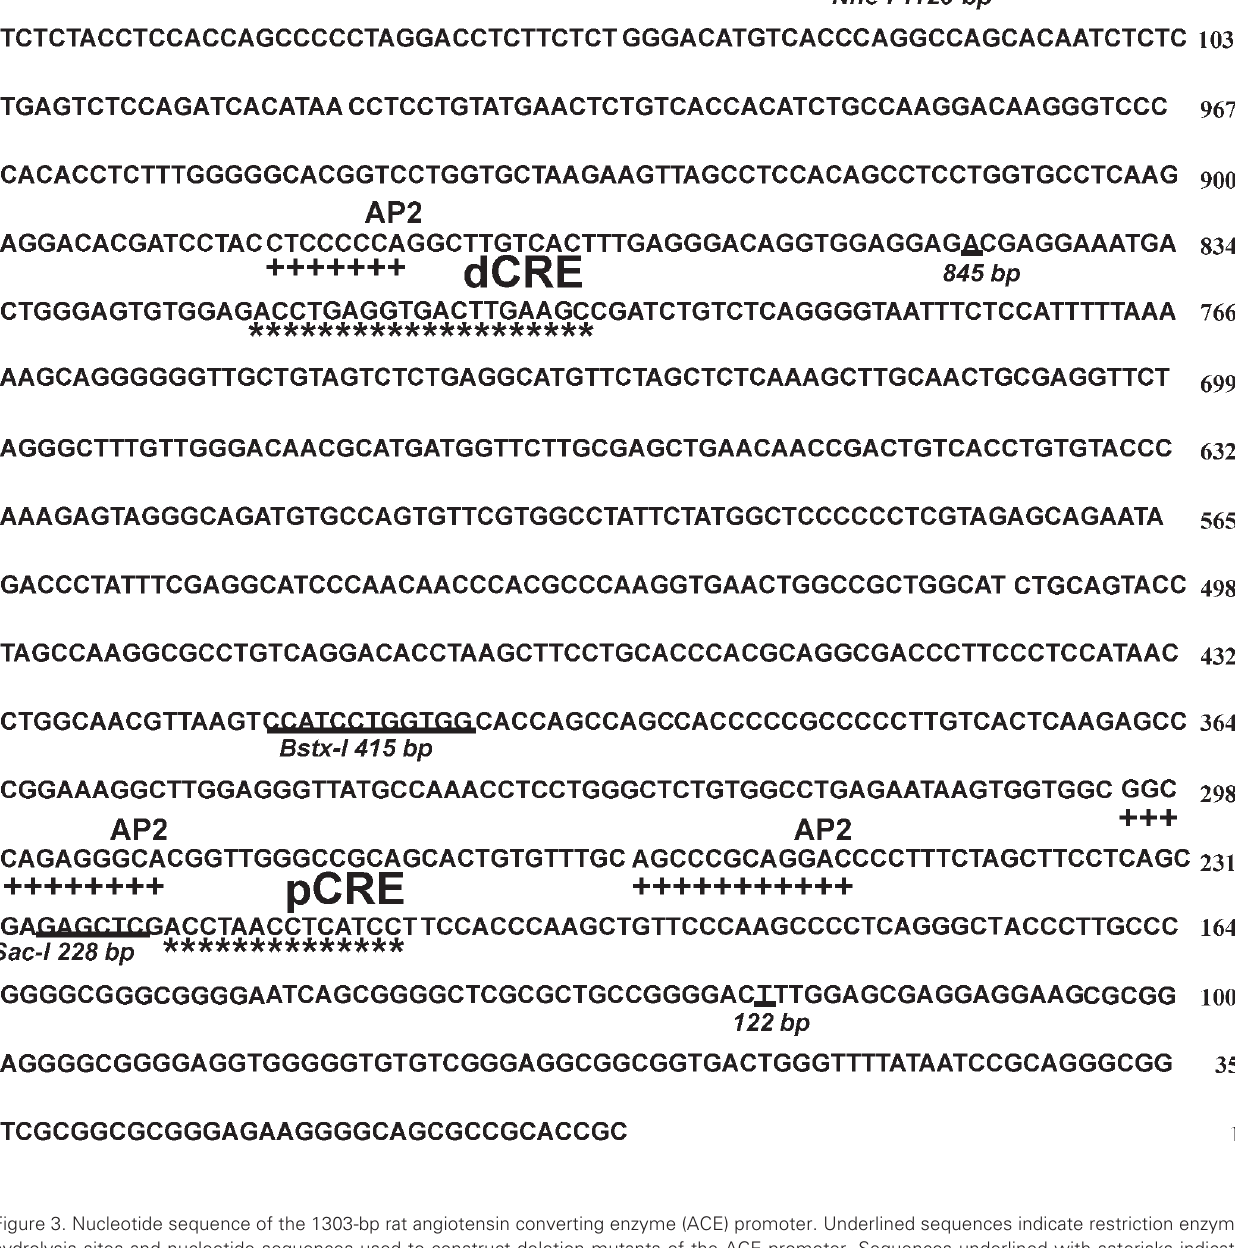
Figure 3. Nucleotide sequence of the 1303-bp rat angiotensin converting enzyme (ACE) promoter. Underlined sequences indicate restriction enzyme hydrolysis sites and nucleotide sequences used to construct deletion mutants of the ACE promoter. Sequences underlined with asterisks indicate cAMP-responsive elements (CRE)-like motifs of the ACE promoter. Sequences underlined with plus symbols indicate AP2 motifs of the ACE